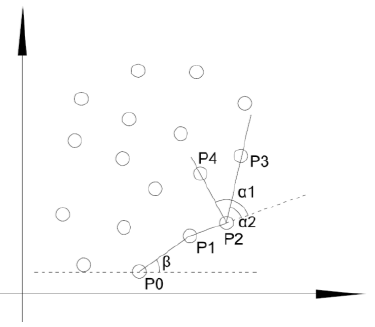
Figure 9. Convex hull determination method of connected risk region.